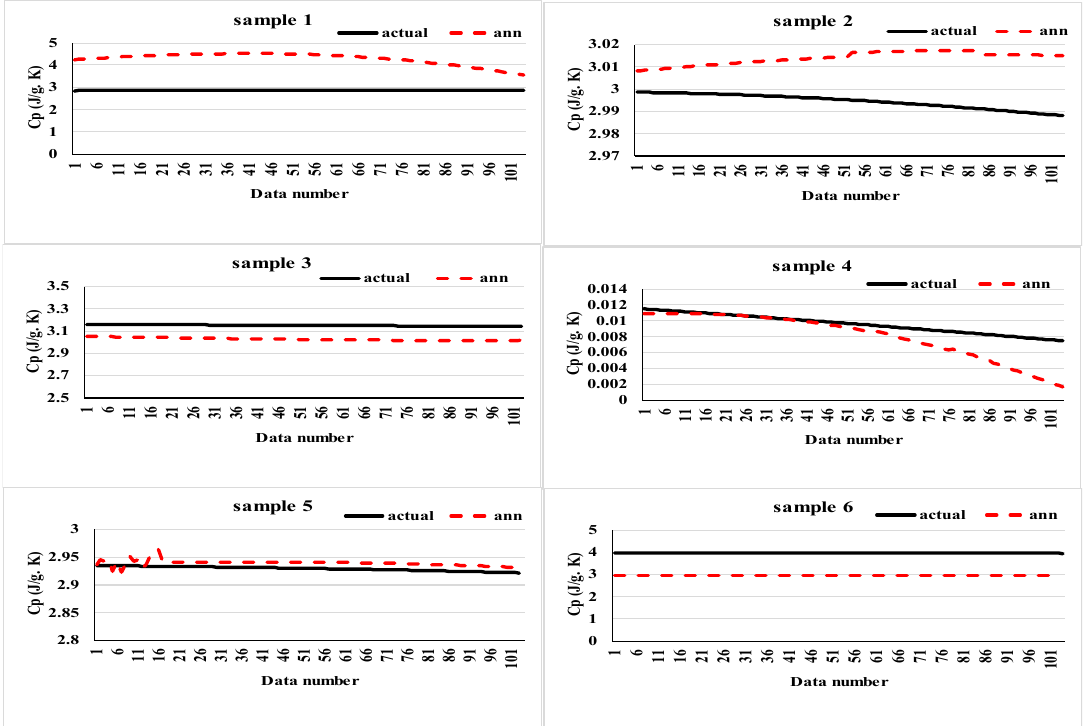
Figure 7. Specific heat capacity validation with the ANN and measured values.